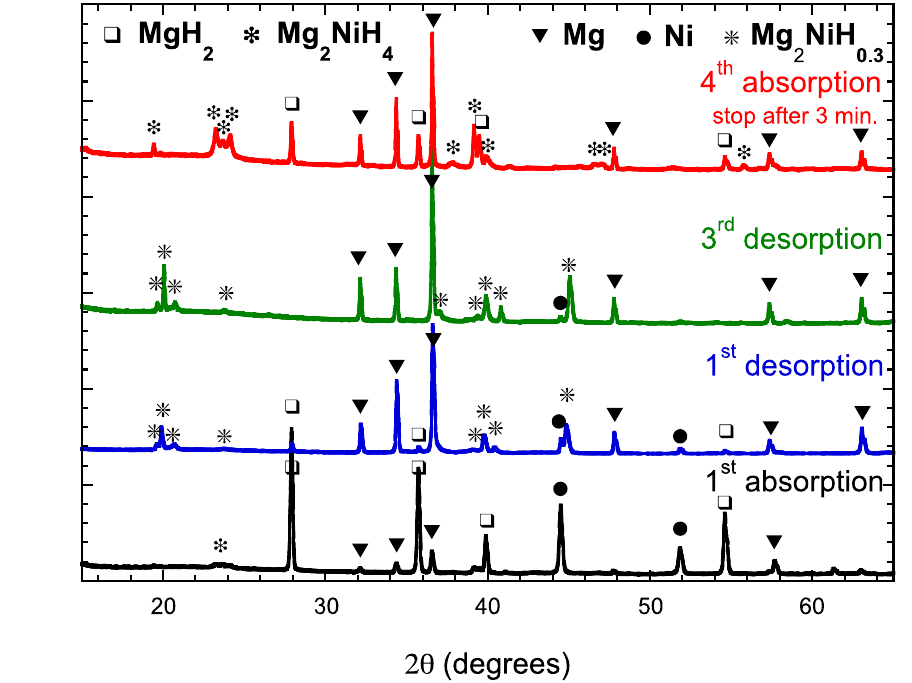
Figure 5. XRD patterns of the Mg-Ni sample forged at room temperature, in the following states: 1st absorption, 1st desorption, 3rd desorption, and 4th absorption stopped after 3 min. Table 1. Weight fraction (%) of phases observed in samples forged at room